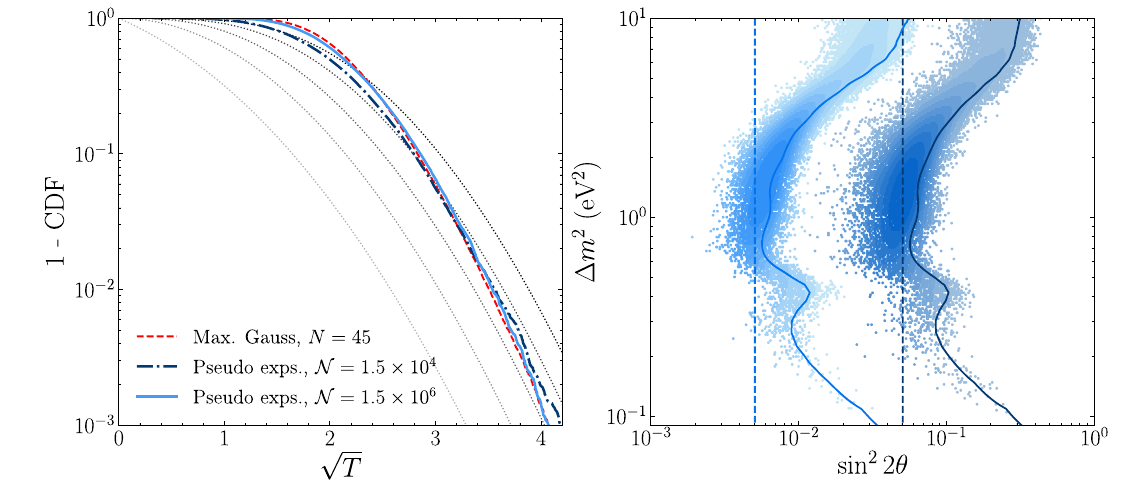
Fig. 2 Left panel: Distribution of the test statistics obtained from numerical simulations for the toy reactor experiment described in the text. For comparison, the red-dashed curves shows the max. Gauss dis- tribution for N = 45. Right panel: location of the best-fit points in the sin 2 2 θ − Δ m 2 plane, after minimization over nuisance parameters. In both panels, darker (lighter) blue lines/points correspond to the results obtained for N = 1 . 5 × 10 4 ( 1 . 5 × 10 6 ) events, using a sample of 20,000 pseudo-experiments simulated under the no-oscillation hypoth- esis. In the right panel, the regions with a higher density of best-fit